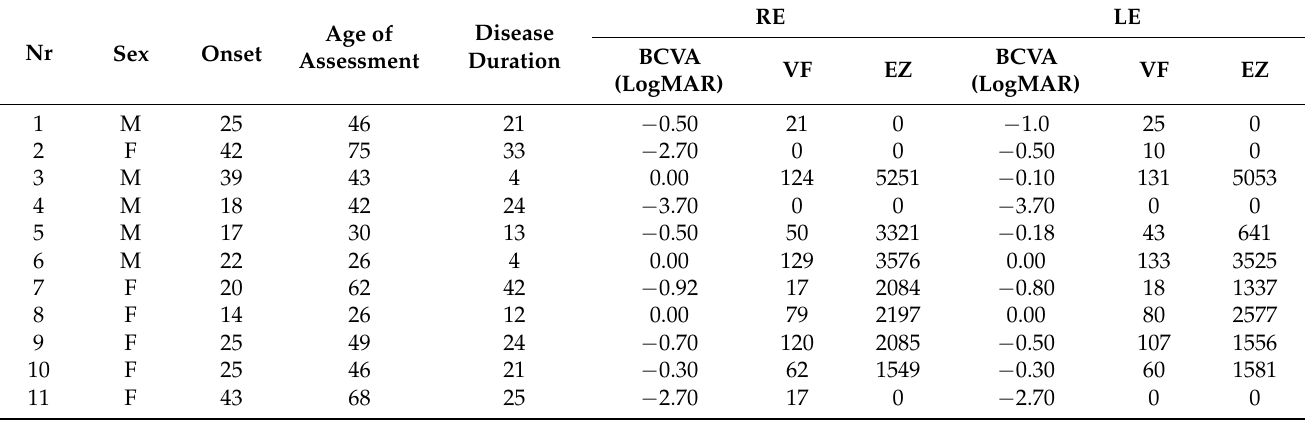
Table 2. Demographic and clinical data of studied